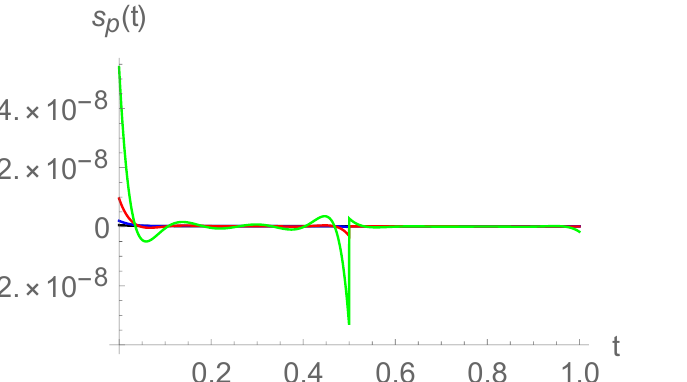
Figure 7. The effect of υ on the distribution of s p ( t ) . Black: υ = 0.2, Blue: υ = 0.4, Red: υ = 0.6, Green: υ = 0.8.